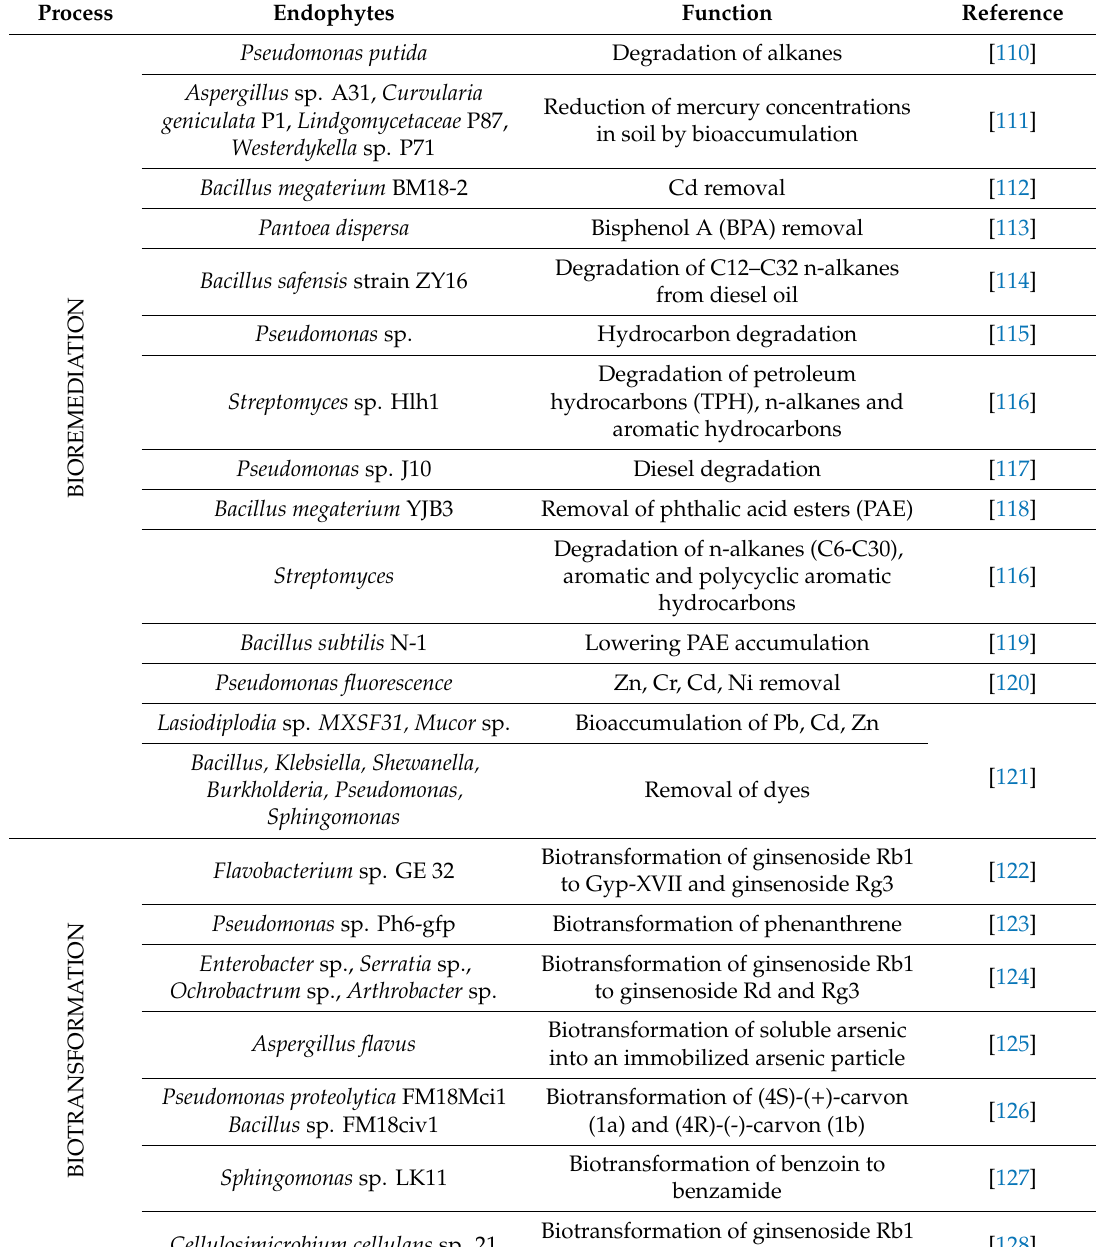
Table 3. Examples of endophytic strains applied for bioremediation and biotransformation